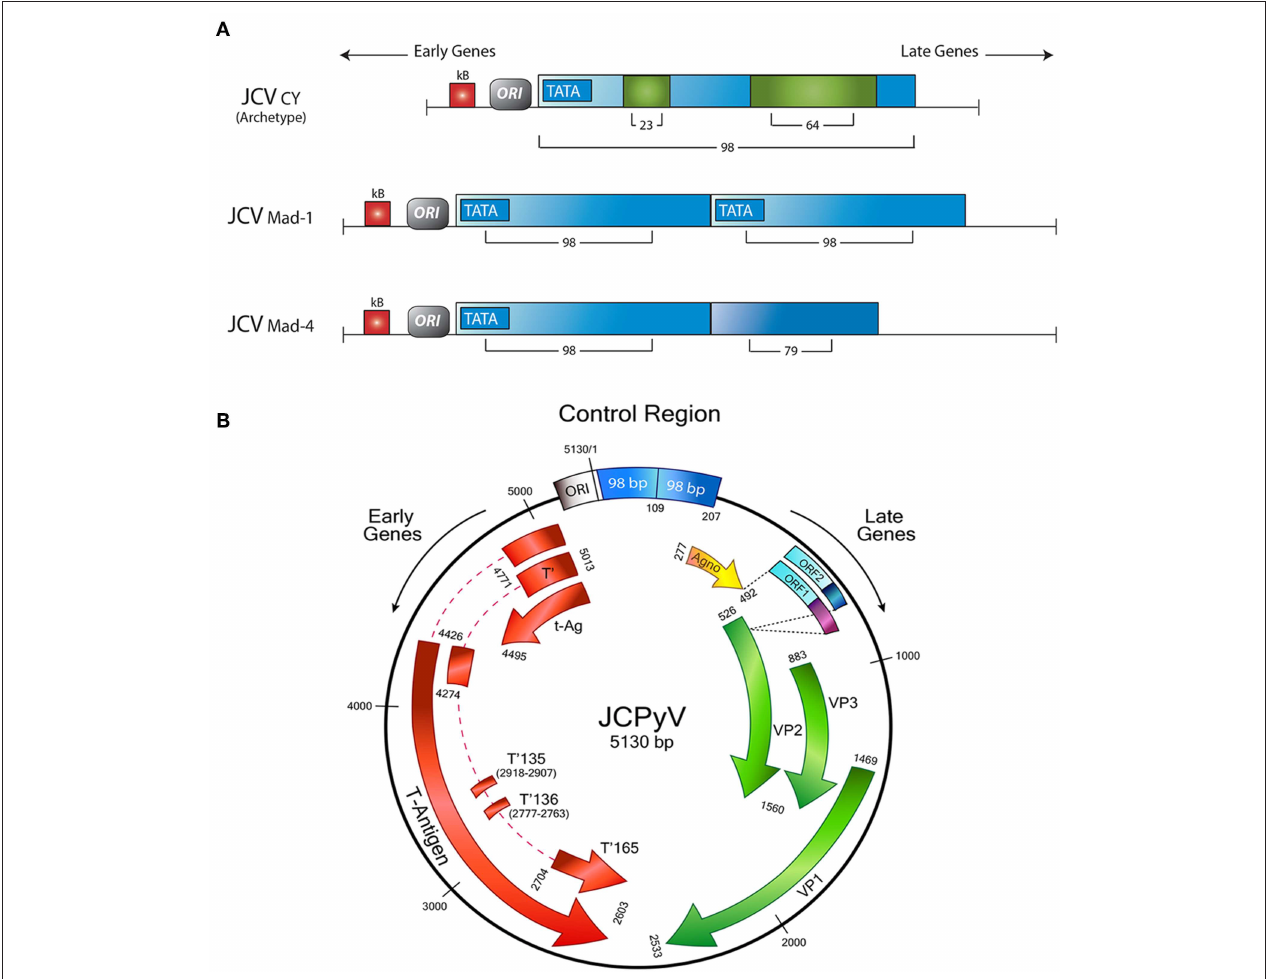
FIGURE 1 | Schematic representation of the JCPyV genome. (A) The control regulatory region determines the strain of JCPyV. The archetype strain in composed of 98 base pairs, with 2 insertions of 23 and 64 respectively. The Mad strains are characterized for a duplication of the control region; Mad-1 contains two 98 base pairs, while in Mad-4, the second repeat has a deletion of 19 base pairs. (B) The control region divides the Early and Late genes. The Early transcriptional region encodes for Large T-Antigen, and the smaller splice versions, small t-Antigen, T’135, T’136, and T’165. On the other side, the late transcriptional region contains the genes for the accessory agnoprotein and the capsid proteins VP-1, VP-2, and VP-3. In addition two new Open Reading Frames have been discovered between the Agno y VP1 genes. Modified from original with permission from Del Valle et al. (